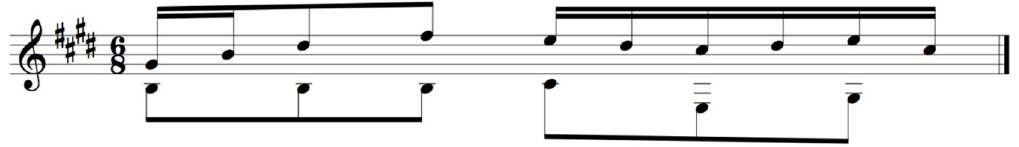
Figure 1. Gigue, measure 10, of J.S. Bach’s Lute Suite BWV 1006a.